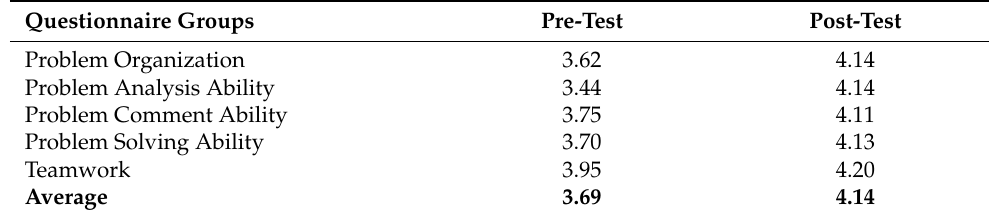
Table 8. Results of the questionnaire groups.